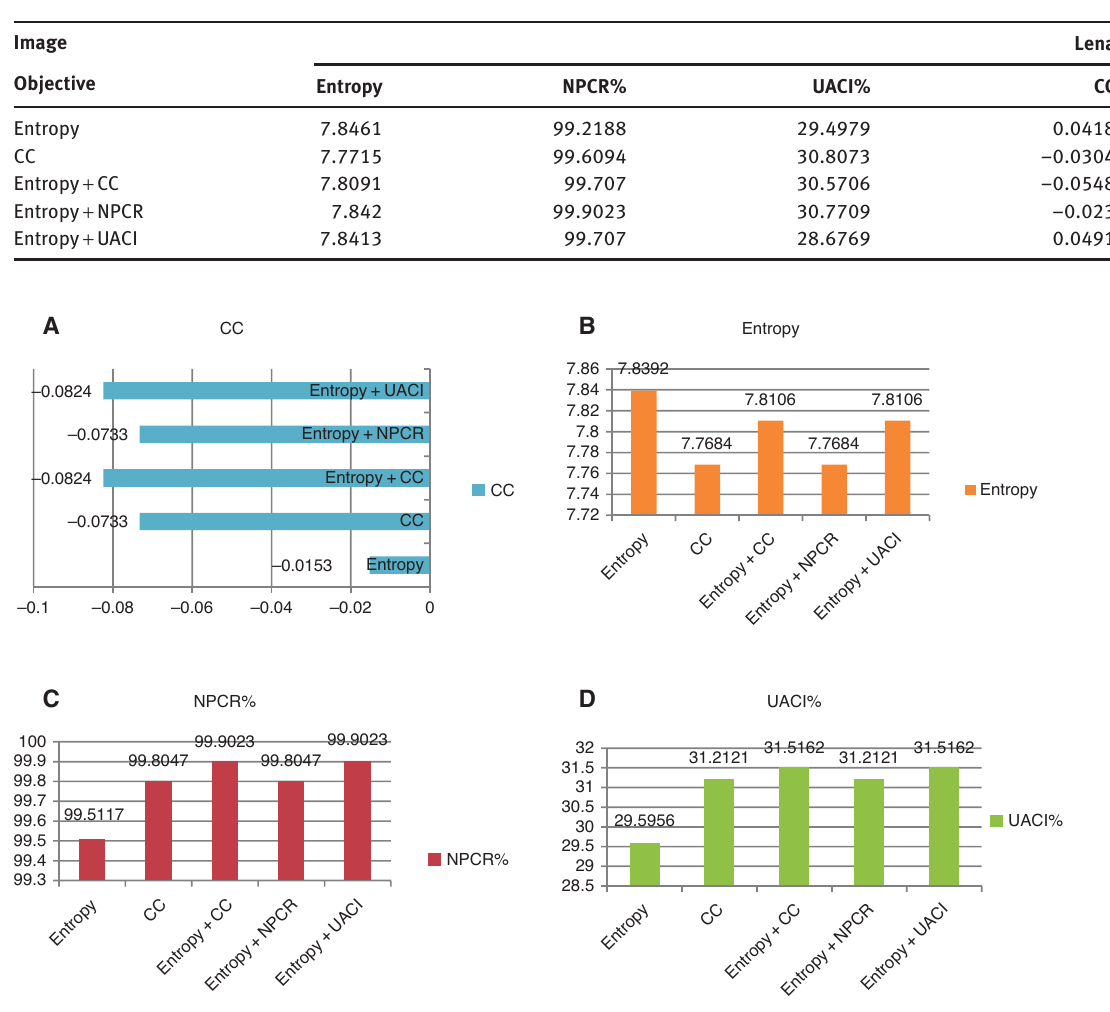
Table 4: Comparative Analysis for Lena Image Using Logistic Map Function.